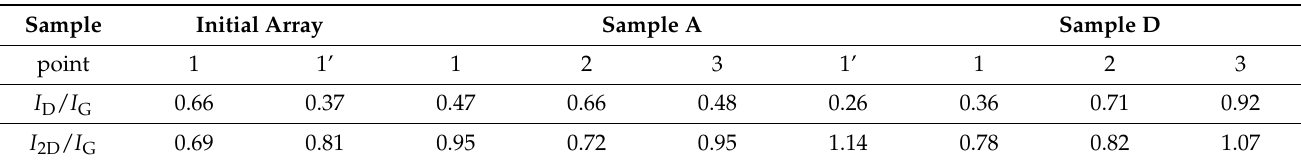
Table 1. Ratios of Raman band intensities for the initial array, Sample A, and Sample D determined from the spectra collected at different array points as indicated in Figure